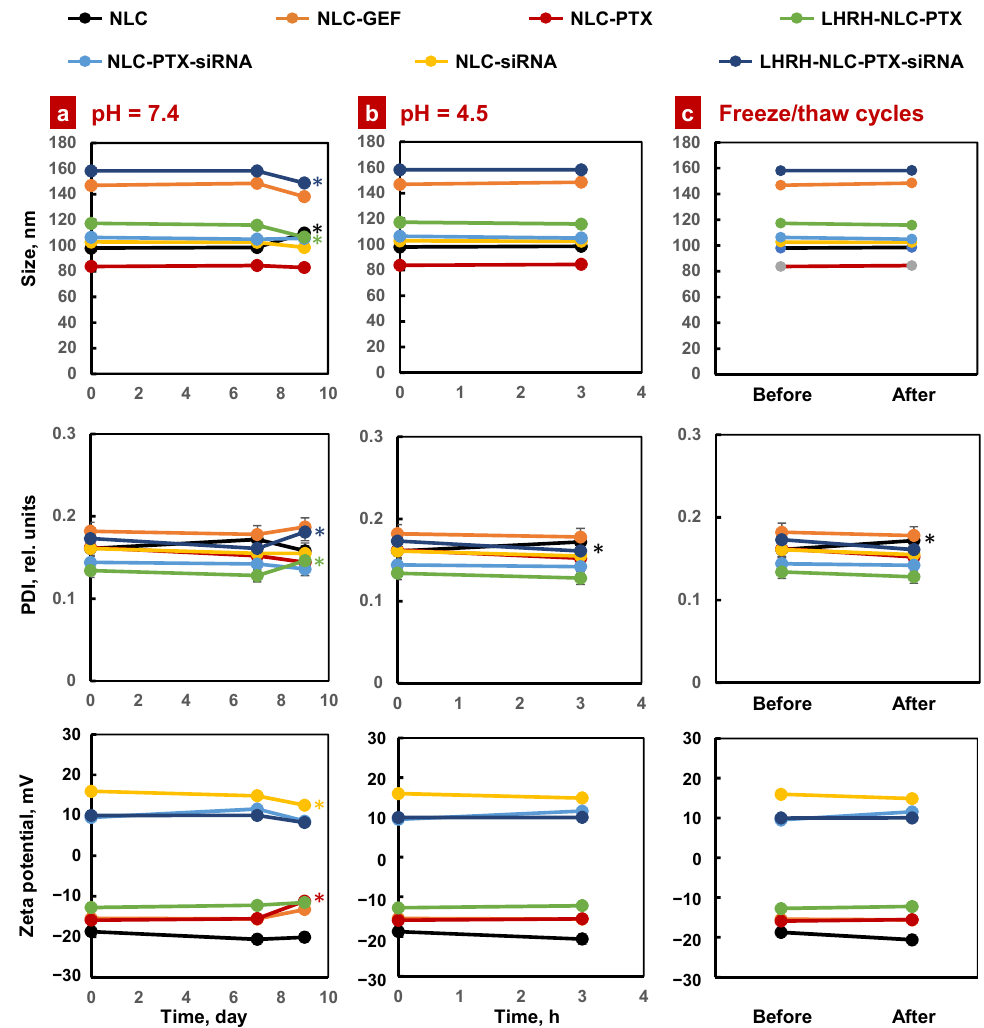
Figure 5. Stability of different NLC formulations in various storage conditions: ( a ) Aqueous solution with normal pH; ( b ) Aqueous solution with low pH; ( c ) Three freeze–thaw cycles (one freeze cycle represents 12 h storage at − 20 °C and one thaw cycle represents 12 h storage at room temperature). Means ± SD are shown (note that in most cases, SD values are too small to be seen on the figure). * p < 0.05 when compared with the day